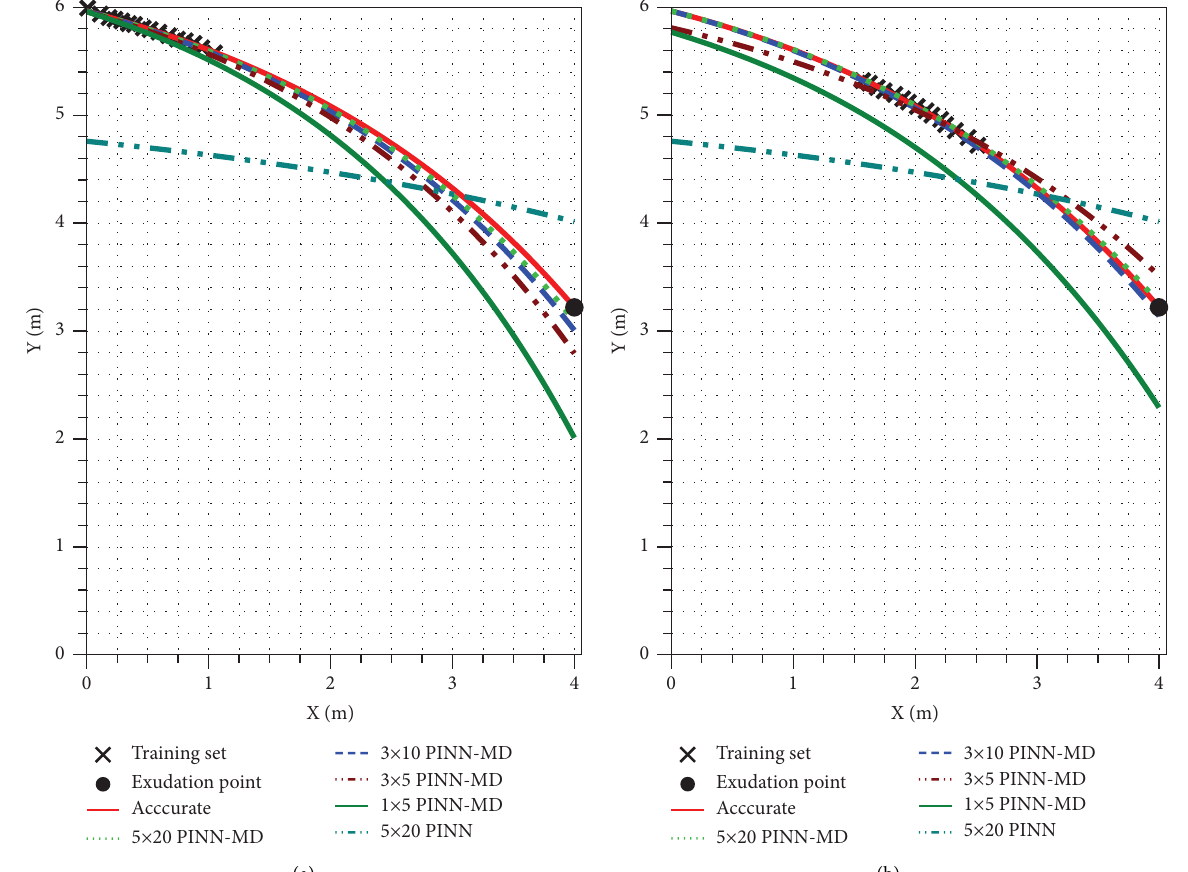
Figure 5: Prediction curves obtained using PINN-MD with diferent network shapes for a rectangular dam with upstream data (a) and middle section data (b)